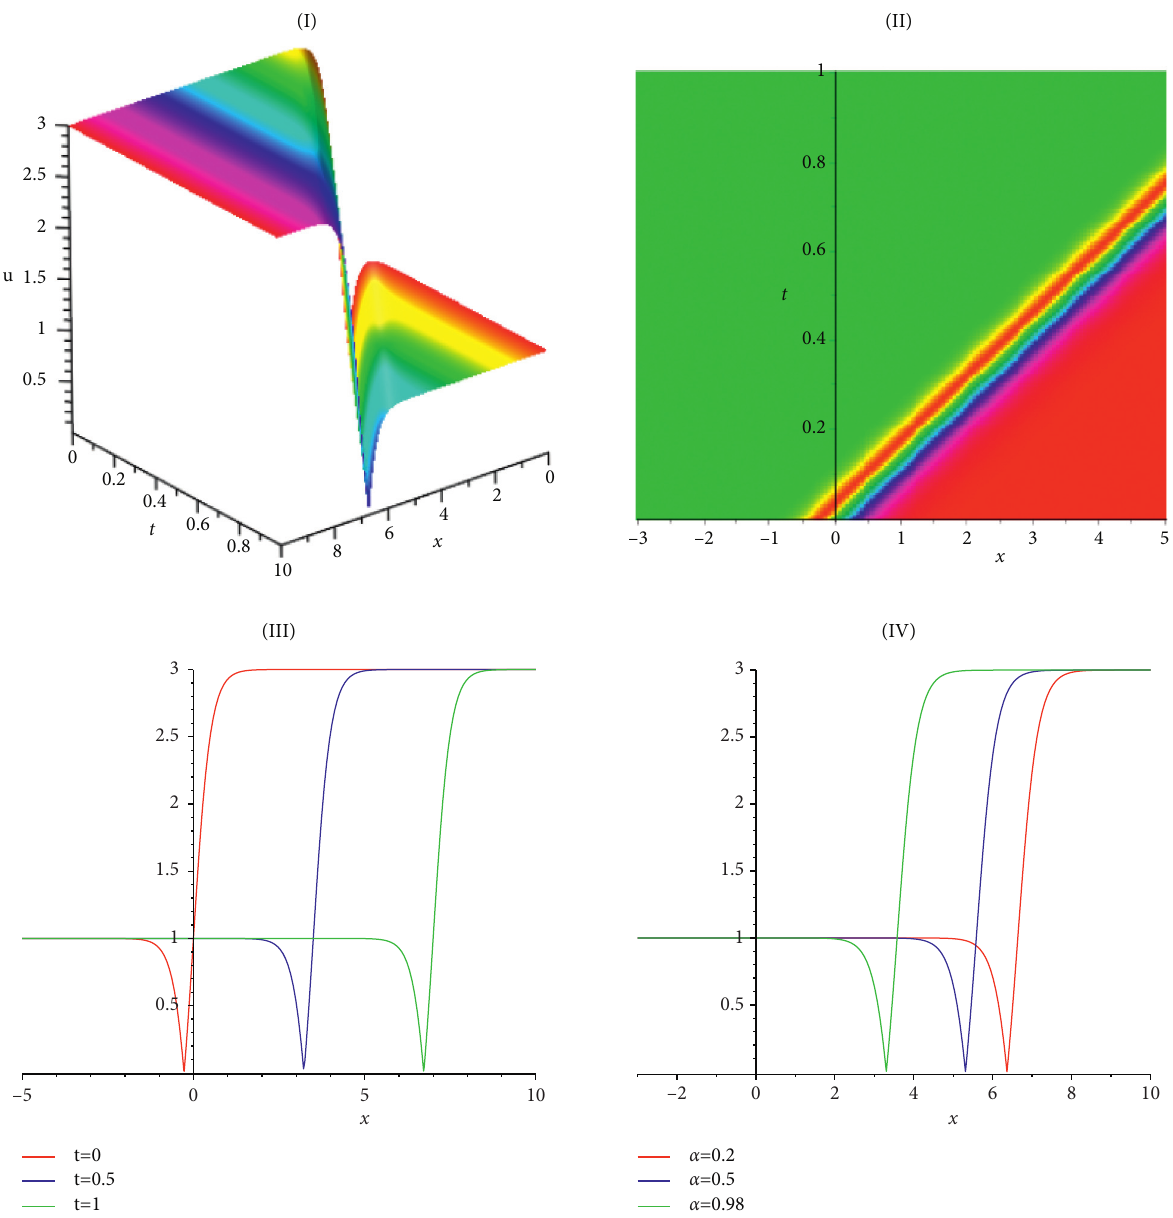
Figure 6: Evolution of the periodic solution (26) with data r � , k